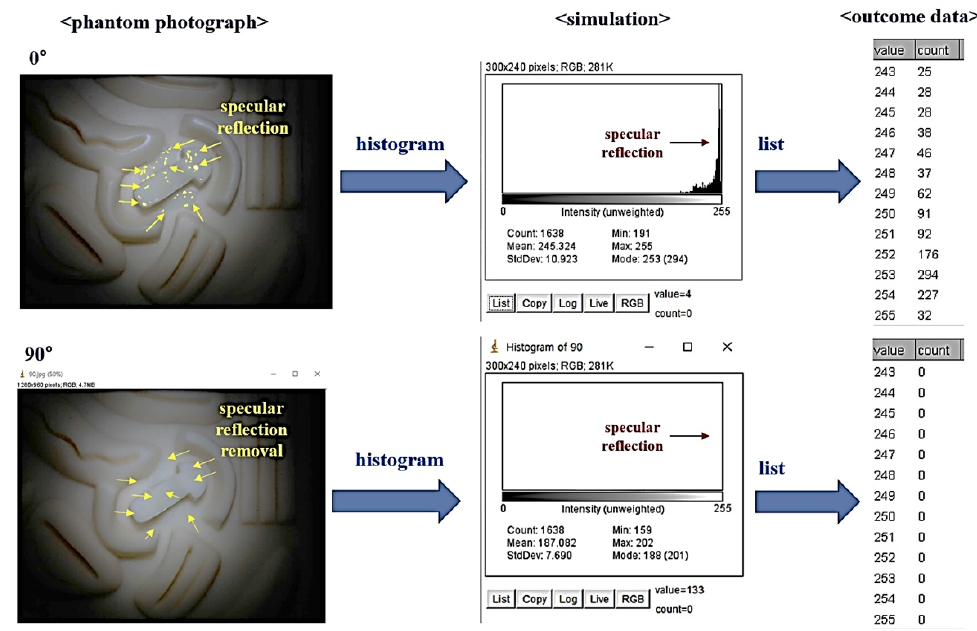
Figure 10. ROI Numerical analysis of Phantom experiment results for specular reflection removal.